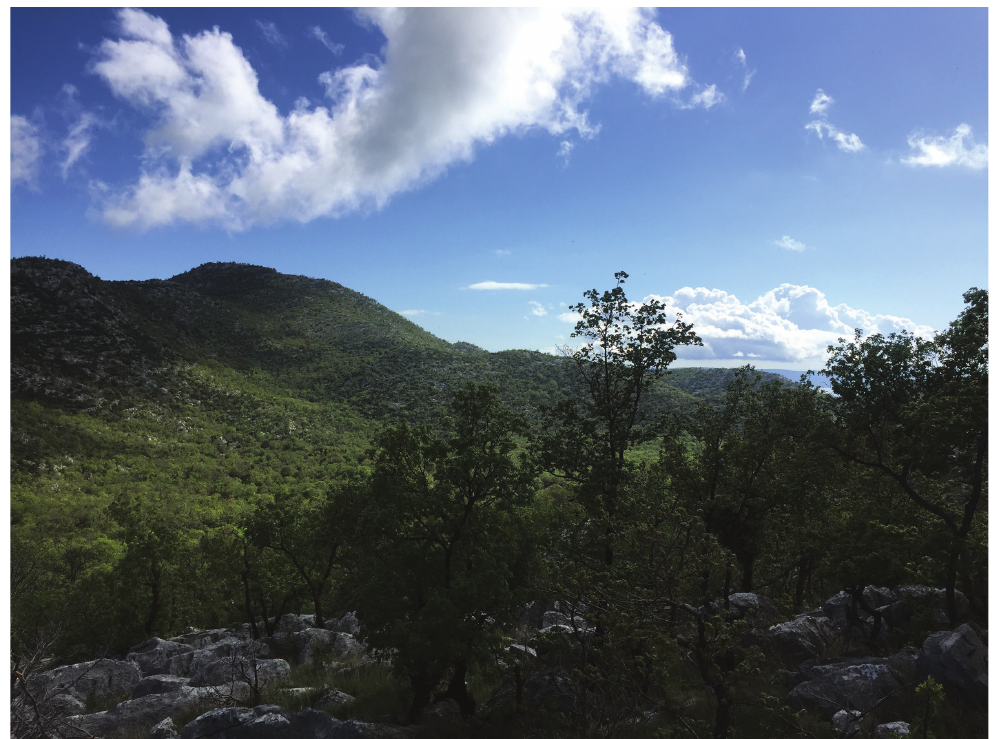
Figure 1. Hillside near Podgora, Croatia, where M. facetella specimens were collected.